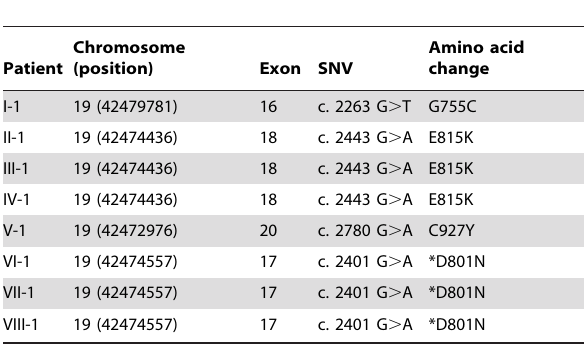
SNV: single nucleotide variation, *D801N was initially not considered a novel mutation but confirmed later by re- analysis. doi:10.1371/journal.pone.0056120.t002 PLOS ONE |